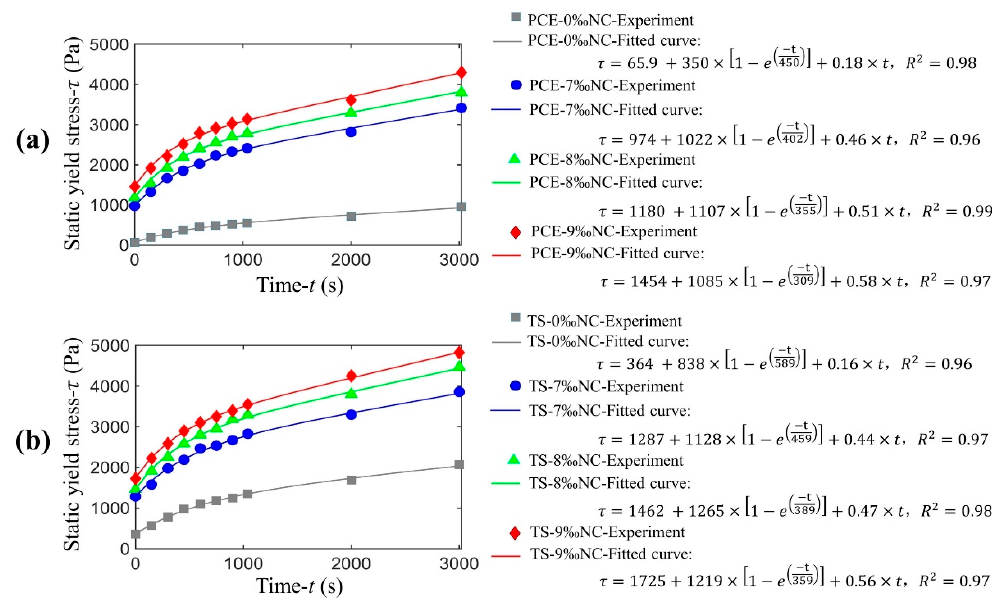
Figure 8. Experimental results and fitted curve of static yield stress of ( a ) mixture with PCE polymer, and ( b ) mixture with TS polymer with resting time. Table 4. Fitted parameters for each cement mixture.